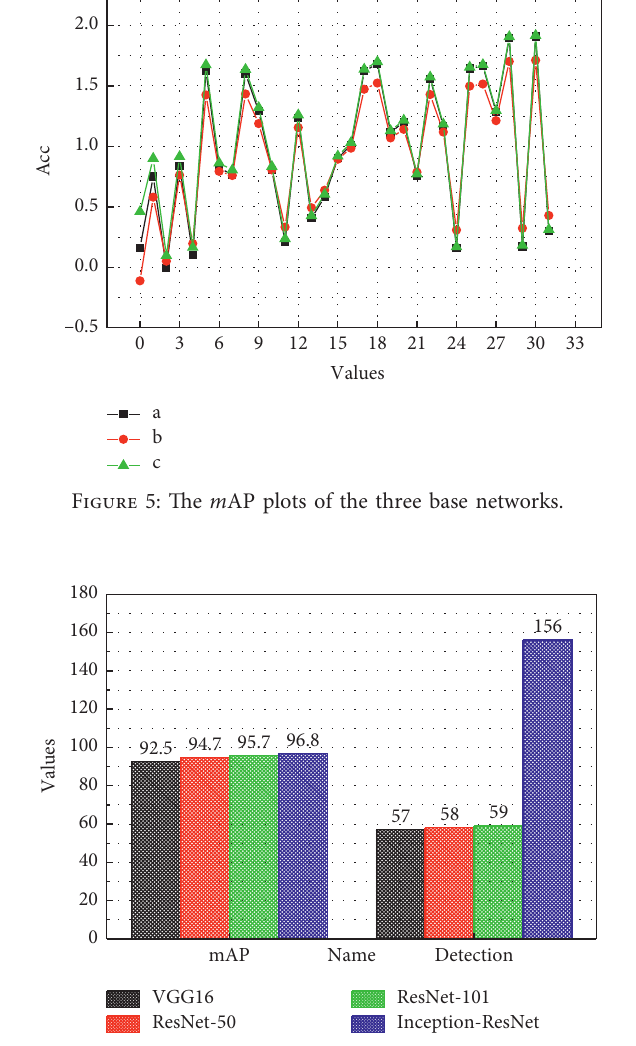
Figure 6: Test results of different base networks.